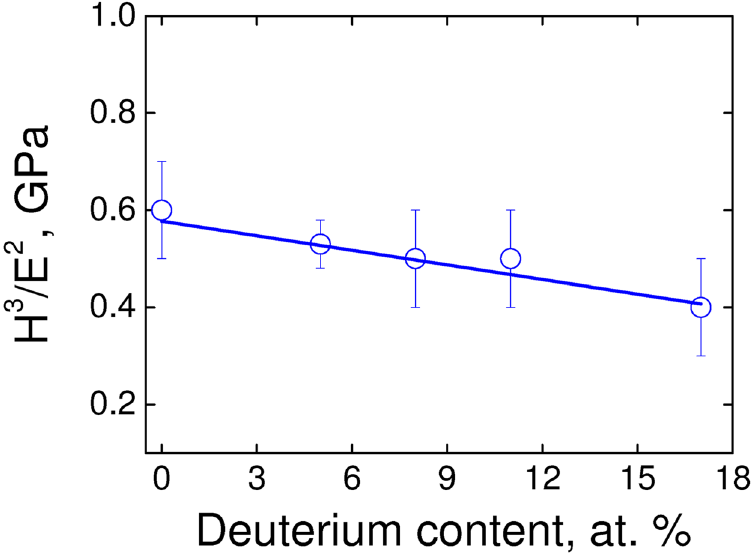
Figure 3. H 3 /E 2 ratio as a function of the deuterium content in the a-C:D/H thin films (isotopic systems).